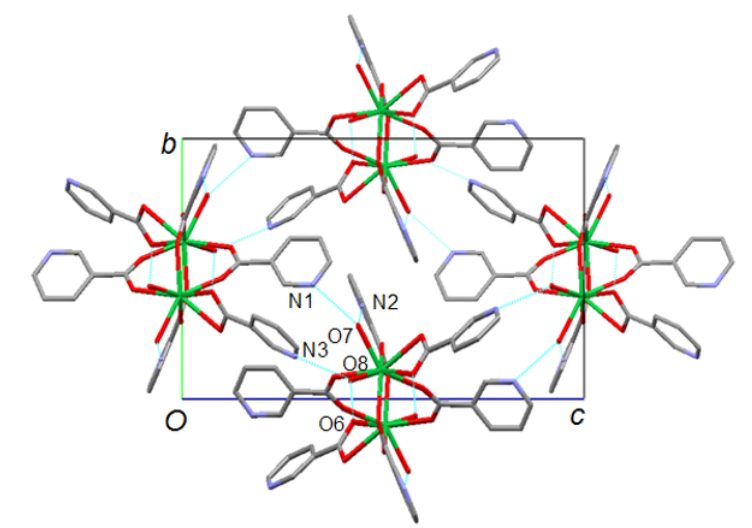
Figure 3. Mercury drawing of crystal packing of molecules in 1 viewed along the a axis. Hydrogen atoms are omitted for clarity. The light-blue lines represent the hydrogen Table 2. Selected bond lengths in (Å) in 1 and 2 .